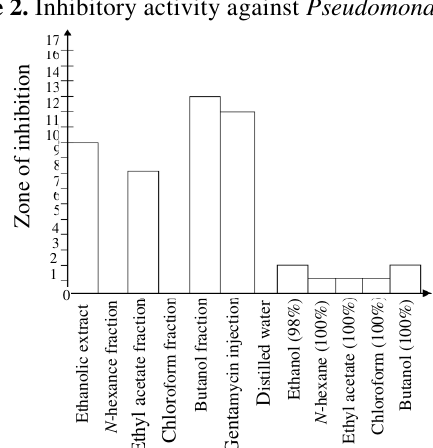
Figure 2. Inhibitory activity against Pseudomonas aeruginos.